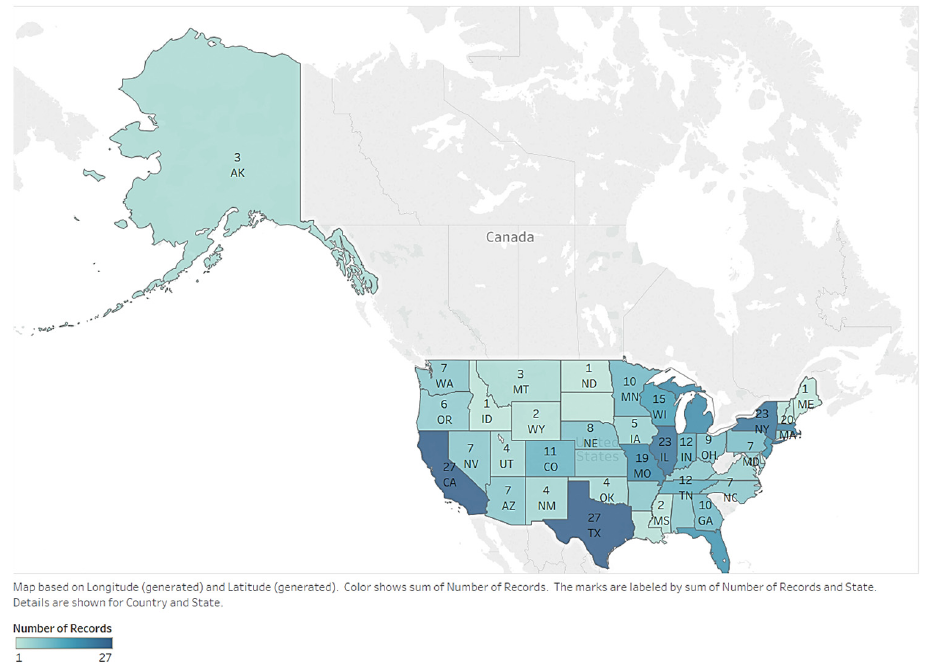
Figure 18. Number of breach records per state.